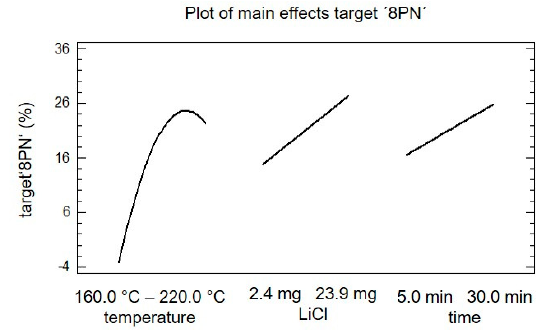
Figure 5. Plot of the main effects of target `8PN` concerning the factors temperature, lithium chloride, and time.